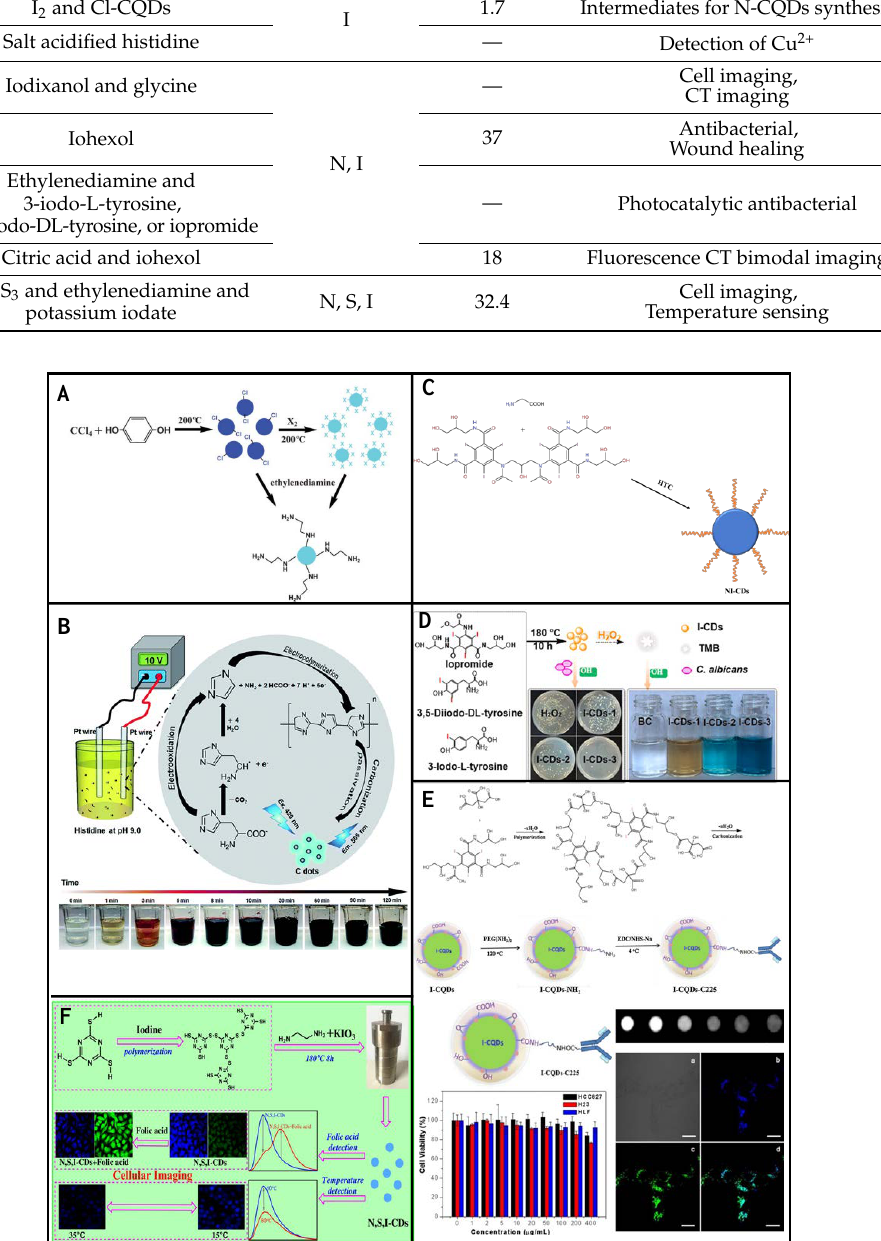
Figure 8. Synthesis and applications of I-doped CDs. ( A ) Solvothermal synthesis of Cl-CQDs as the intermediates and I 2 as the modifier to convert the Cl-CQDs into I-CQDs; both CQDs can function as intermediates. ( B ) Schematic of I-CQDs preparation by electrolysis. ( C ) Hydrothermal synthesis of NI-CDs by iodixanol and glycine can be used as a cell imaging and CT contrast agent. ( D ) NI-CDs synthesized using ethylenediamine and 3-iodo-L-tyrosine, 3,5-diiodo-DL-tyrosine, or iopromide exhibit photocatalytic antibacterial activity in the presence of hydrogen peroxide. ( E ) NI- CDs were synthesized via the hydrothermal method with citric acid and iodohexanol as precursors for application as fluorescent CT bimodal imaging probes. ( F ) NSI-co-doped CDs were prepared for application in folic acid and temperature sensing, and cellular imaging. Reprinted/adapted with permission from Refs. [57,92]. Copyright 2013, 2019 copyright RSC. Reprinted/adapted